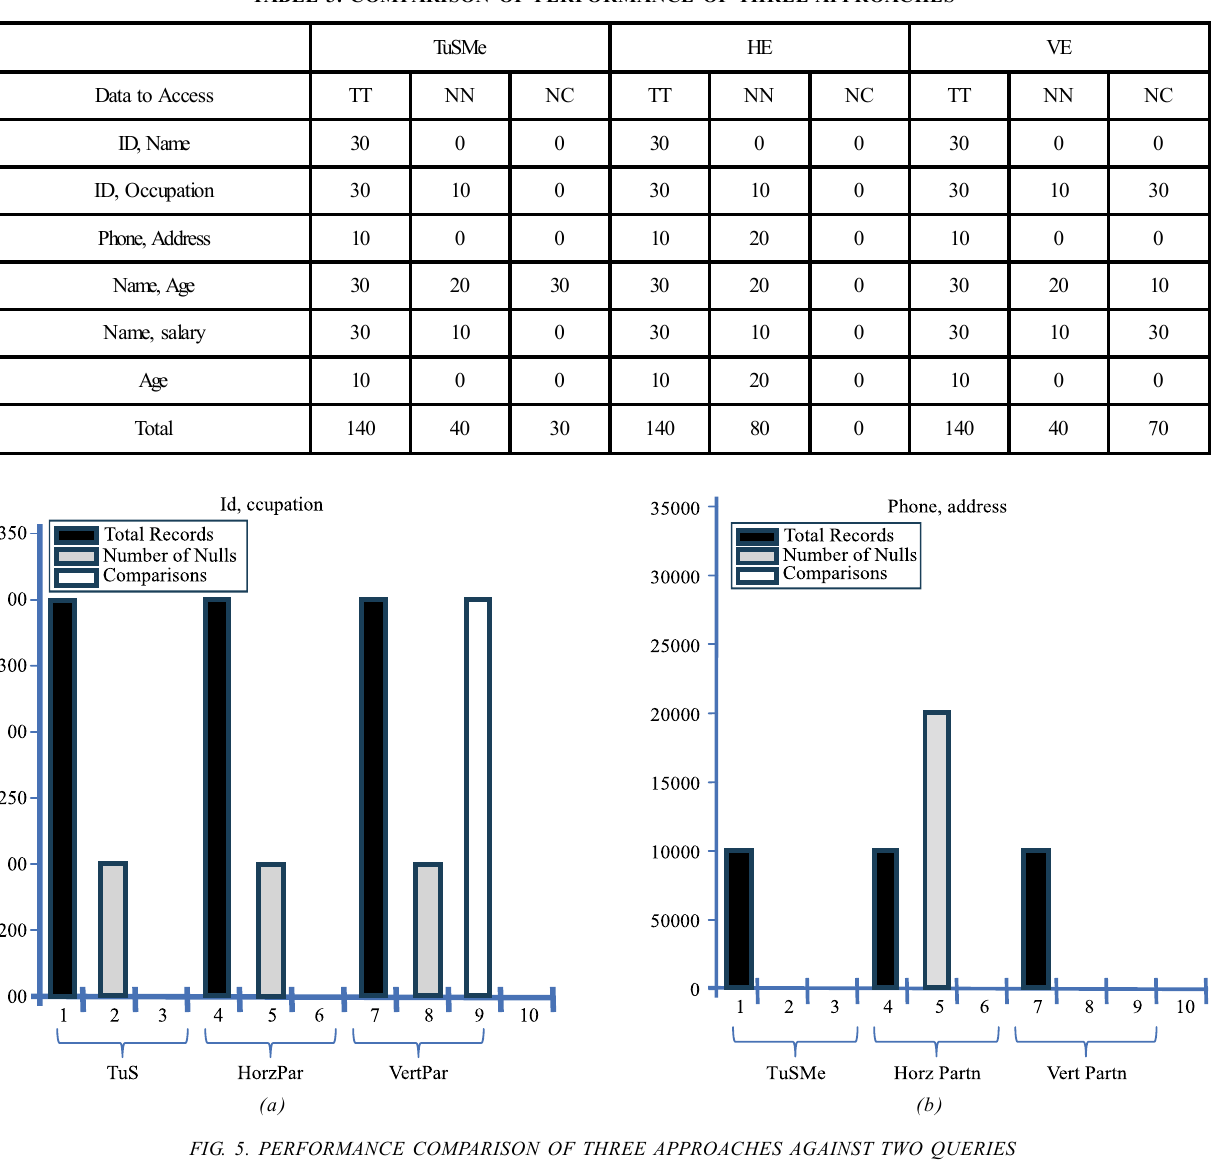
FIG. 5. PERFORMANCE COMPARISON OF THREE APPROACHES AGAINST TWO